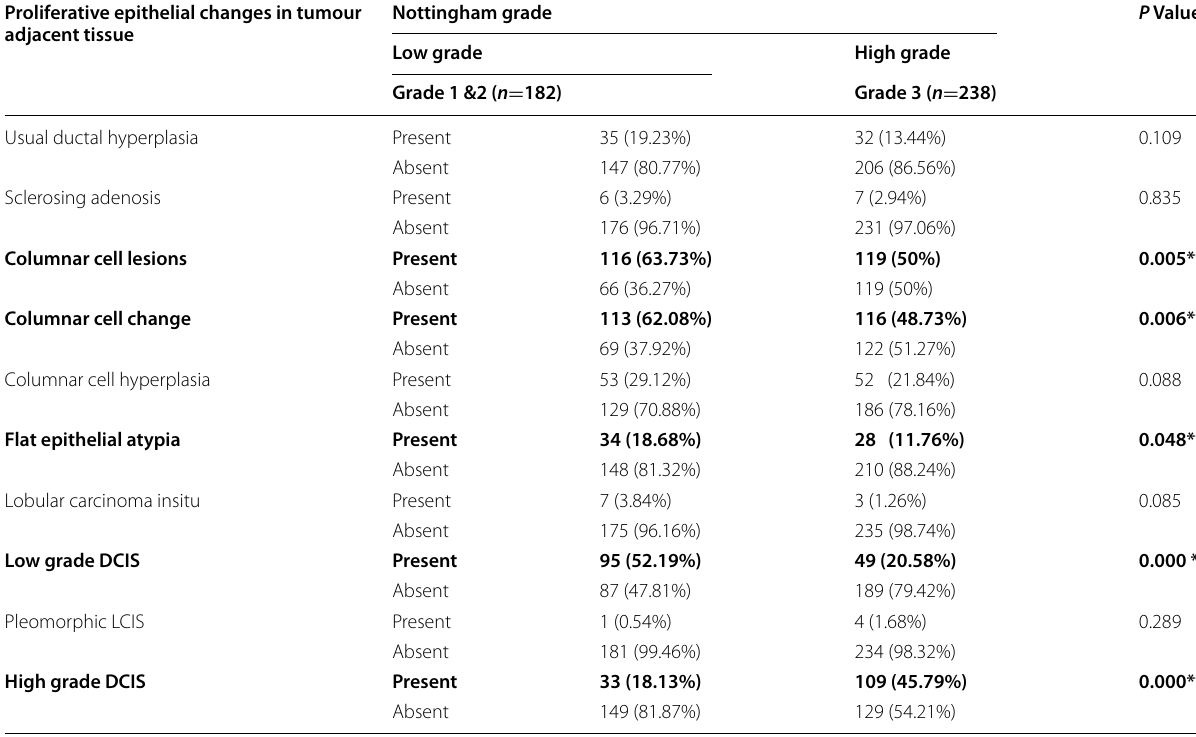
Table 3 Association between proliferative epithelial changes in tumour adjacent tissue and Nottingham grade of the tumour Proliferative epithelial changes in tumour adjacent